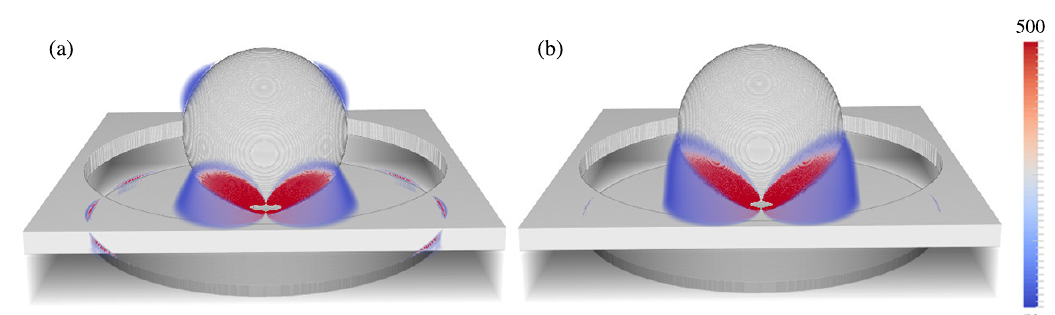
Figure 10. Plot of electric field intensity at ( a ) λ = 785 nm and ( b ) λ = 857 nm for optimized NW with imbedded 300 nm diameter nanoparticles. The optimal parameters are D = 650 nm, RD = 100 nm, P = 700 nm, and MT = 40 nm with an O . F . =